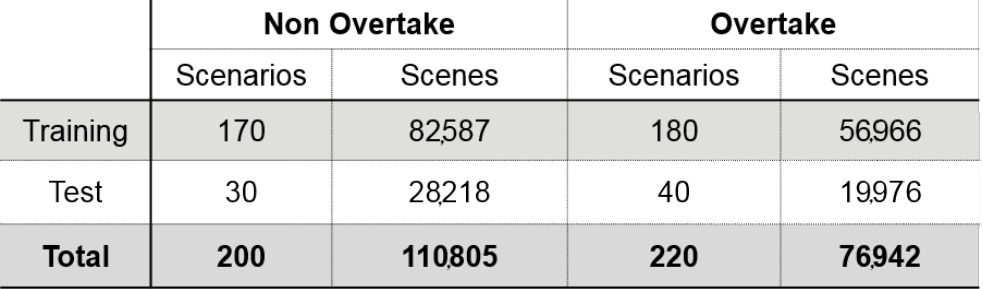
Figure 7. Demonstration